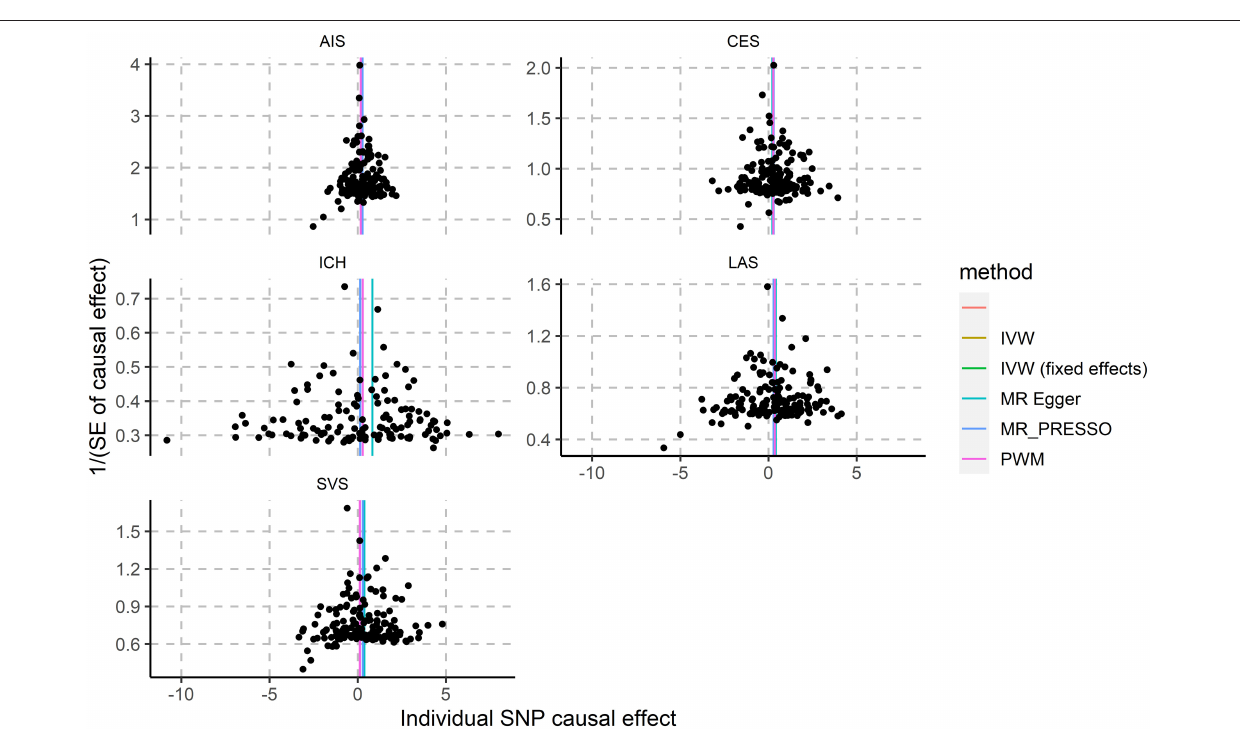
FIGURE 1 | Association of genetically-predicted VAT mass with ICH and ischemic stroke subtypes. AIS, all ischemic stroke; CES, cardioembolic stroke; LAS, large artery stroke; SVS, small vessel stroke.